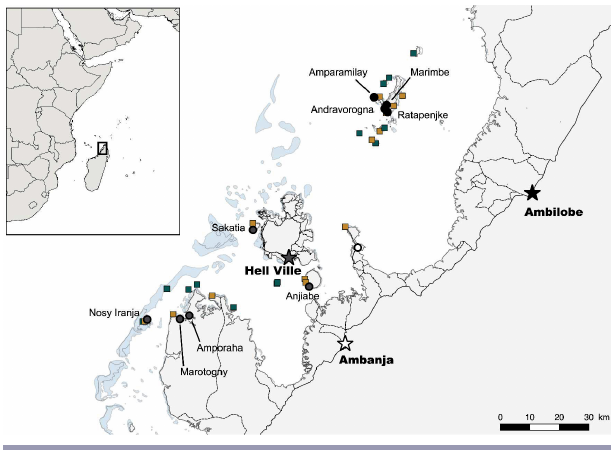
Fig. 1 . Map of the study area located off the southeast coast of Africa in northwest Madagascar. Surveyed reefs where fishing is permitted (open access and restricted reefs: orange squares) or fishing is prohibited (no-take zones within the two forms of management: green squares), coastal communities (circles), local markets (stars), and cartography of reefs (blue shades) are represented. Each coastal community is colored according to its nearest market (Ambilobe: black; Ambanja: white, Hell Ville: